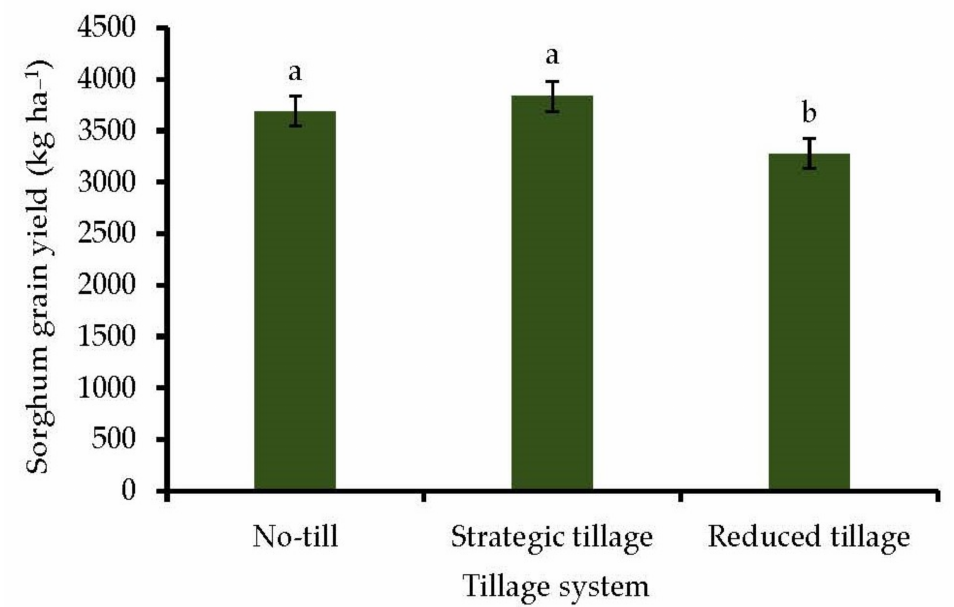
Figure 5. Grain sorghum yield as affected by tillage averaged over 2017 and 2018 growing seasons at Hays, KS. Means followed by the same lower-case letter (s) within are not significantly different using the least squares means (LSMEANS) and adjusted Tukey multiple comparison procedure ( p >